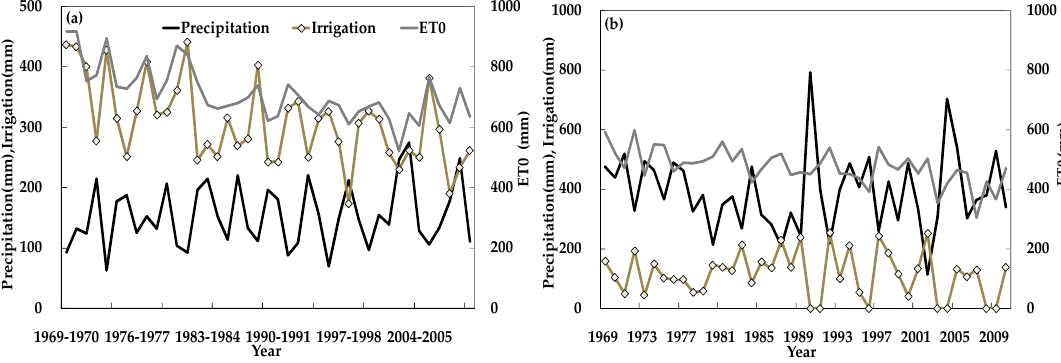
Figure 6. Annual variation in precipitation, irrigation, and reference evapotranspiration during different growing seasons. ( a ) Winter wheat season; and ( b ) summer maize season. ET 0 is reference evapotranspiration. Table 7. Mann–Kendall test and Sen’s slope estimator for climate and irrigation variables during the winter wheat and summer maize seasons from 1969 to 2010.